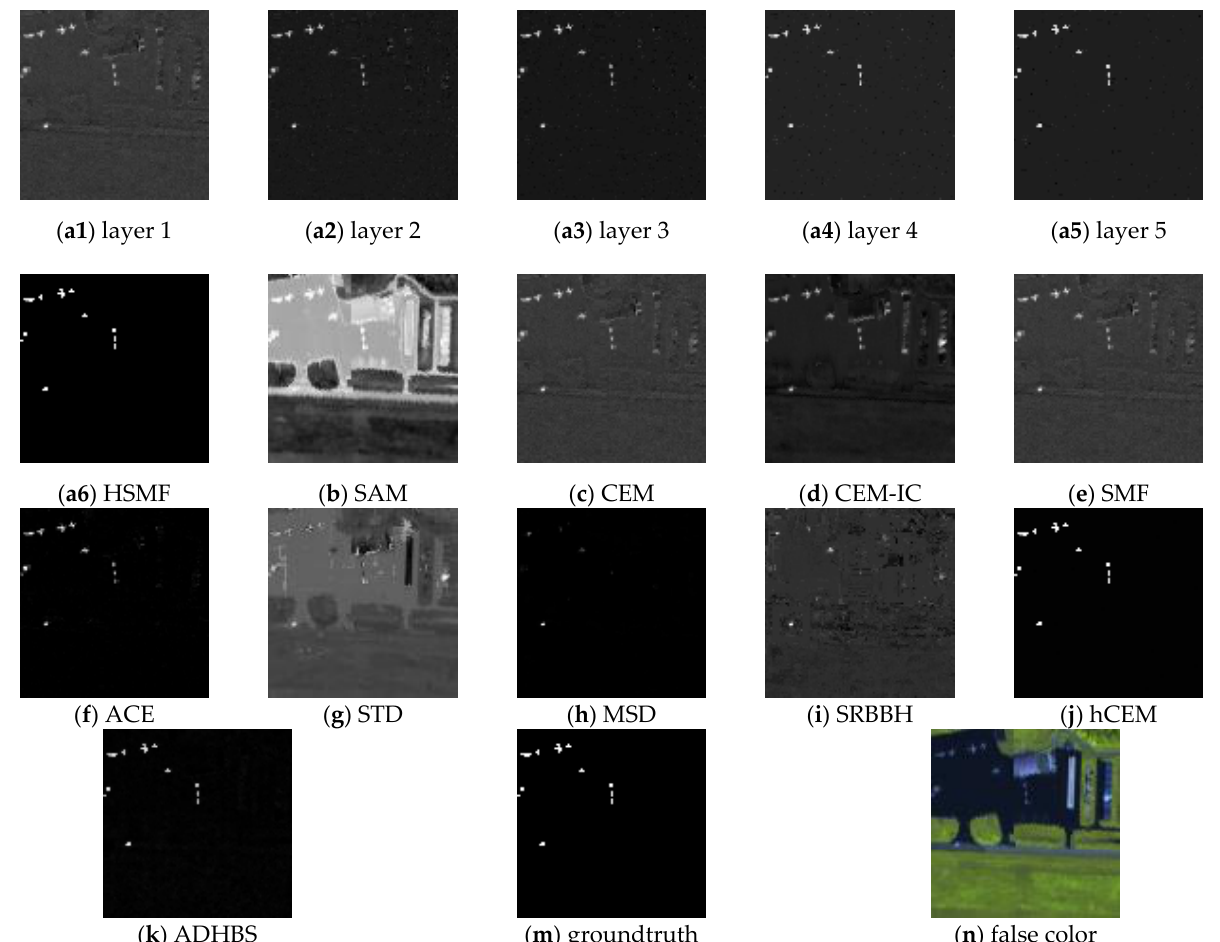
Figure 5. Detection results of the Airport-Beach-Urban data. ( a1 – a5 ): Results of HSMF for the first to the fifth layers. ( a6 ): The final result of HSMF. ( b – k ): Results of SAM, CEM, CEM-IC, SMF, ACE, STD, MSD, SRBBH, hCEM, and ADHBS. ( m ): The groundtruth information. ( n ) The false color image (bands 23, 56, 72).